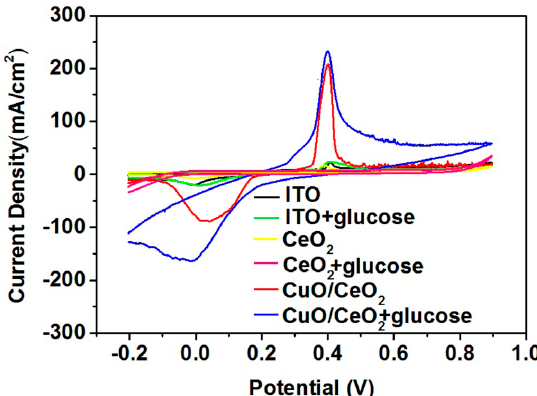
Figure 5. Cyclic voltammograms (CVs) of ITO, CeO 2 /ITO, and CuO/CeO 2 /ITO electrodes in the absence and presence of 5 mM glucose in 0.1 M phosphate buffer (PB) solution at 50 mV/s scan rate.